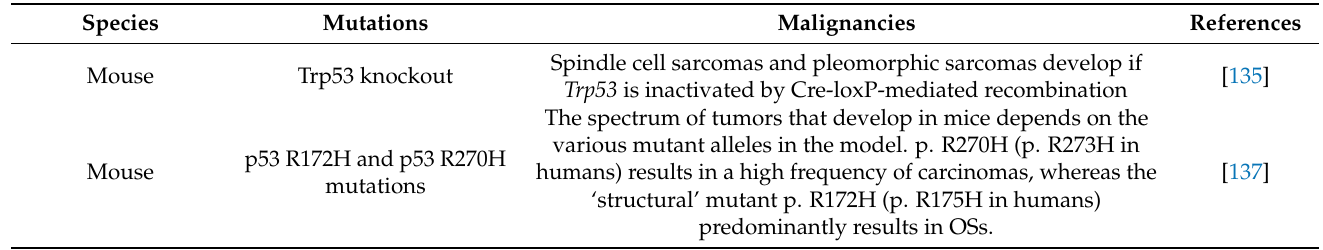
Table 1. Overview of animal models of